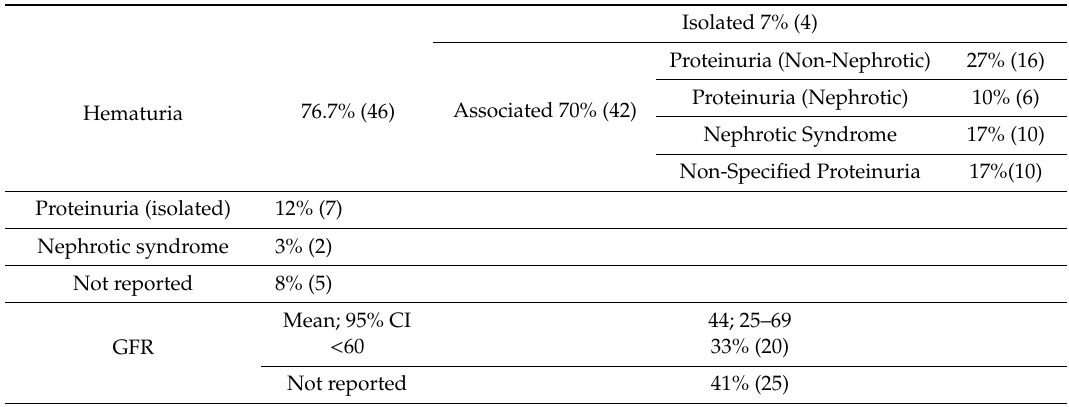
Table 4. Renal abnormalities in HUVS patients with kidney involvement ( n = 60).